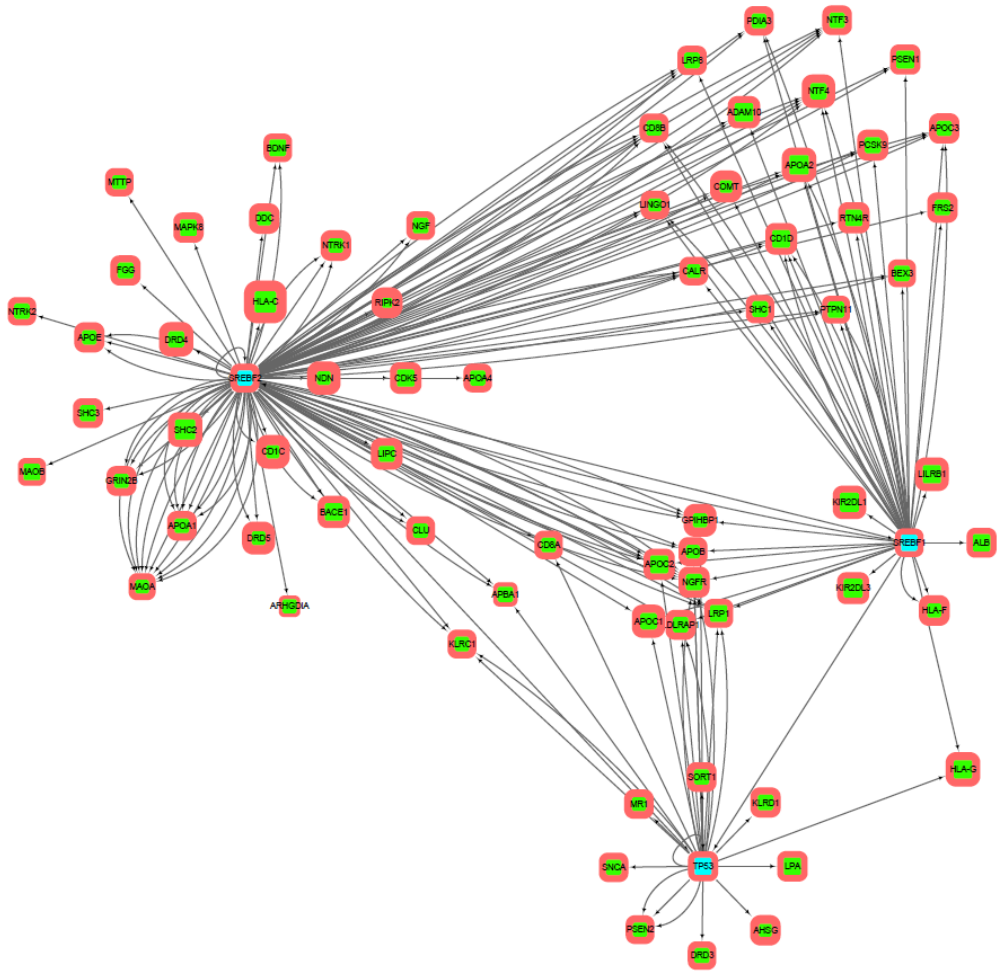
Figure 5. Transcriptional regulation network built on predictions of transcription factor binding sites in upstream promoter regions of 2000 b.p. length. Transcription factors are cyan highlighted, green are regulated genes. Direction of arrows denote regulators (from) and regulated genes (to). The thickness of the frame corresponds to the enrichment of SNP in the upstream promoter region of the gene, the size of the node—the enrichment of SNP in the coding region of the gene.